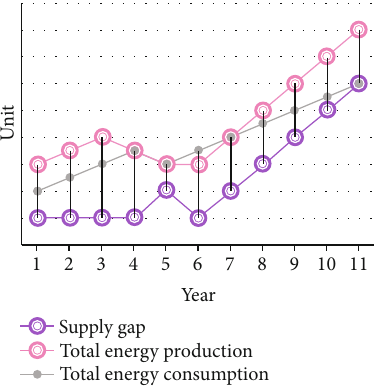
Figure 3: Total amount of energy production and consumption.